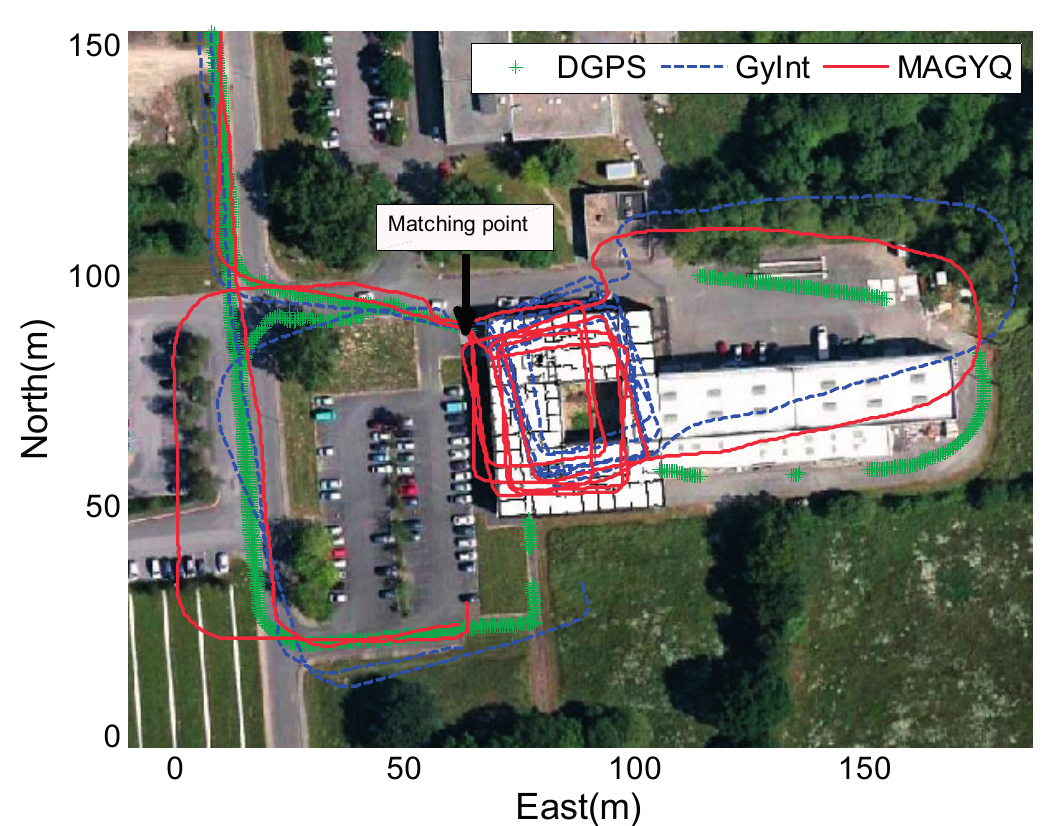
Figure 12. Walking paths of